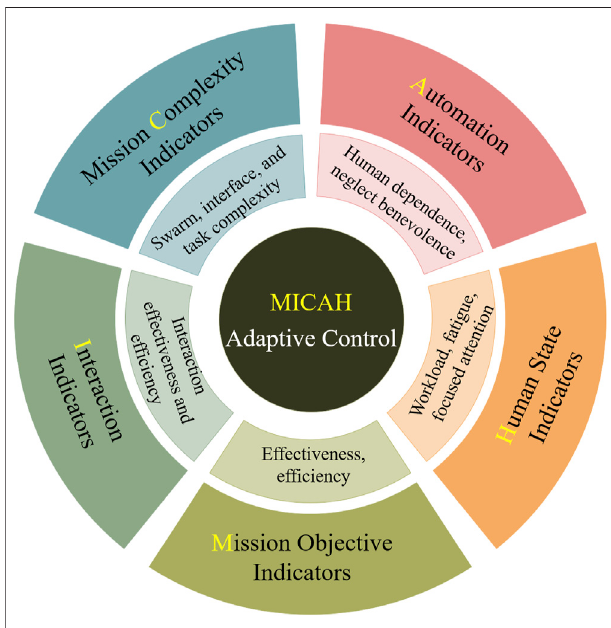
FIGURE6| MICAH: categories ofindicatorsused for adaptationin HST.